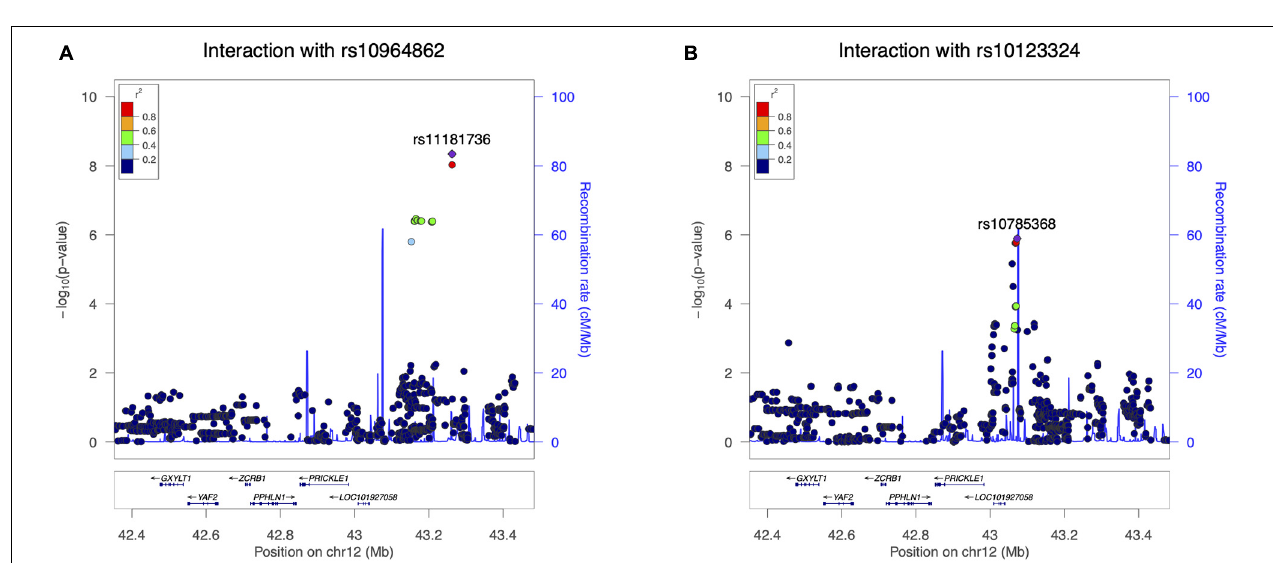
( Figure 7B ). Consistent with the E12.5 results, in the